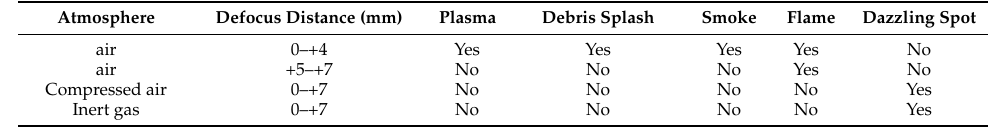
Table 5. Phenomenon during laser paint removal.